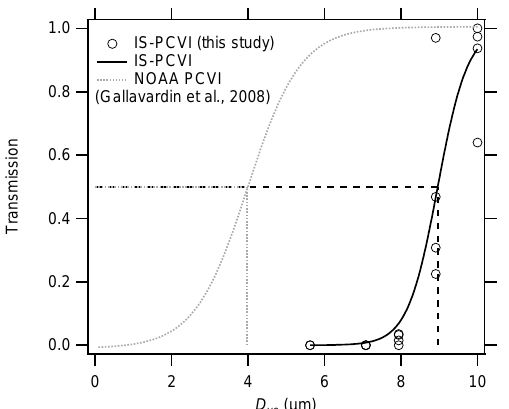
Figure 7. Lower-bound transmission curves of two PCVIs as a function of particle size in D ve . The measurements were car- ried out with the CF-to-IF ratio 0.1 and 0.3–0.4 for the IS- PCVI (INUIT05_29) and the NOAA-PCVI (IN08_13), respec- tively. Crossing-points of dot lines represent 50% cut size.